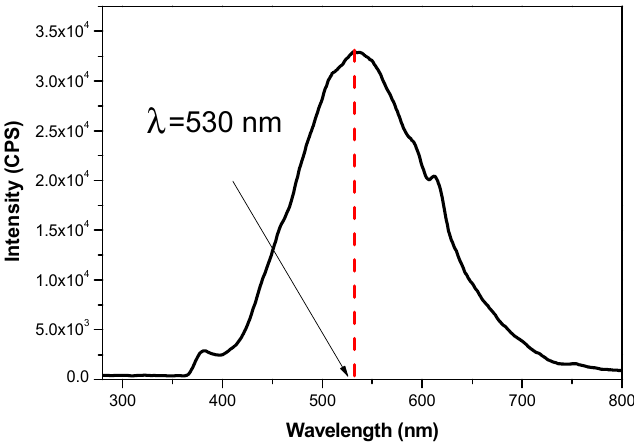
Figure 5. Room temperature PL spectrum for Bi 12 ZnO 20 nanoparticles. UV-visible diffuse reflectance spectroscopy (DRS) studies play an essential role in the estimation of the optical band gap energy (E g ) and electronic structures of the metal oxide semiconductor materials [53,54]. To assess the light absorption of our sillenite Bi 12 ZnO 20 nanopowder, diffuse reflectance spectra were investigated in the range of 200–800 nm at room temperature, as are shown in Figure 6 (inset). From this figure, we see that the sharpness and significant value of the absorption edge at ~475 nm correspond to the band-to-band transition of the sillenite [55]. The diffuse reflectance is transferred to the equivalent absorption coefficient by the Kubelka–Munk function to determine the bandgap energy (E g ) using the Tauc relation [56].